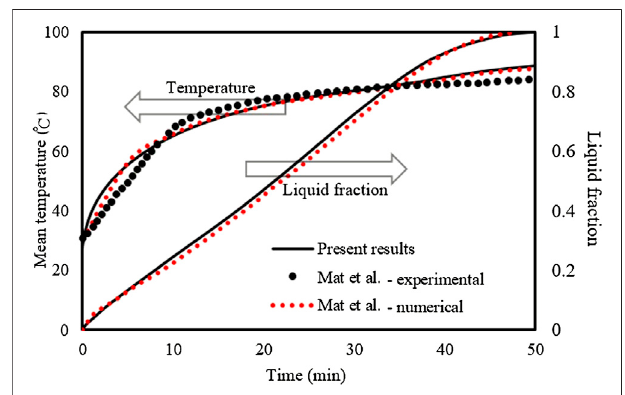
FIGURE 3 | The simulation model ’ s predictions for temperature and the liquid fraction progress compared to those of Mat et al.